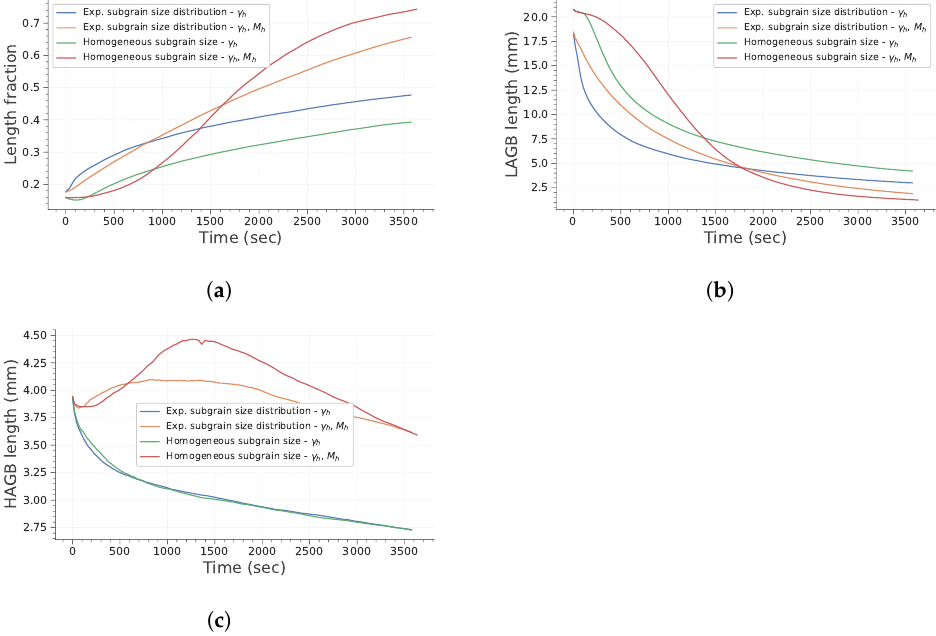
Figure 7. Evolution of GB length with time. ( a ) HAGB length ratio. ( b ) Total LAGB length. ( c ) Total HAGB